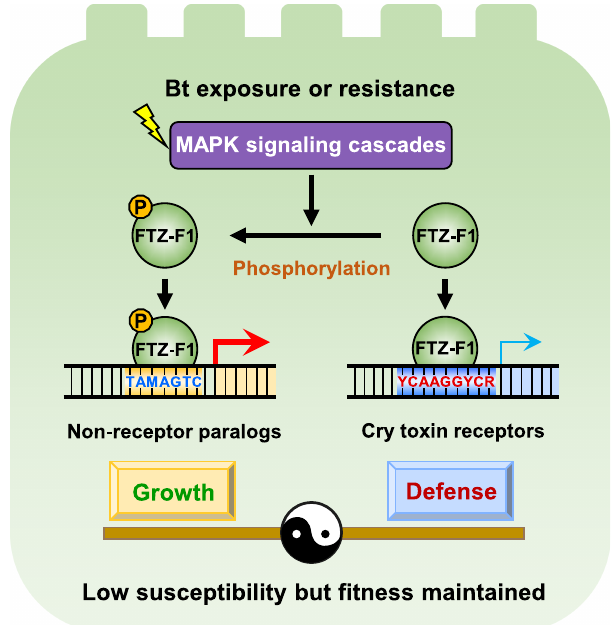
Fig. 8 |Summary modeloftheMAPK-activated regulatorFTZ-F1maintaining a growth-defense balance with enhanced tolerance/resistance of P. xylostella to BtCry1Actoxin. PhosphorylatedFTZ-F1activatesnon-receptorgenesviathemotif “ TAMAGTC ” , while non-phosphorylated FTZ-F1 induces receptor genes via the binding site “ YCAAGGYCR ” . The activated MAPK cascade elevates the phosphor- ylation level of FTZ-F1, reducing the pool of non-phosphorylated TF, leading to upregulation of non-receptor gene expression and downregulation of receptor geneexpression,whichconferstolerance/resistanceof P.xylostella toCry1Actoxin without growth penalty. Degenerate bases: M(A/C); Y(C/T);